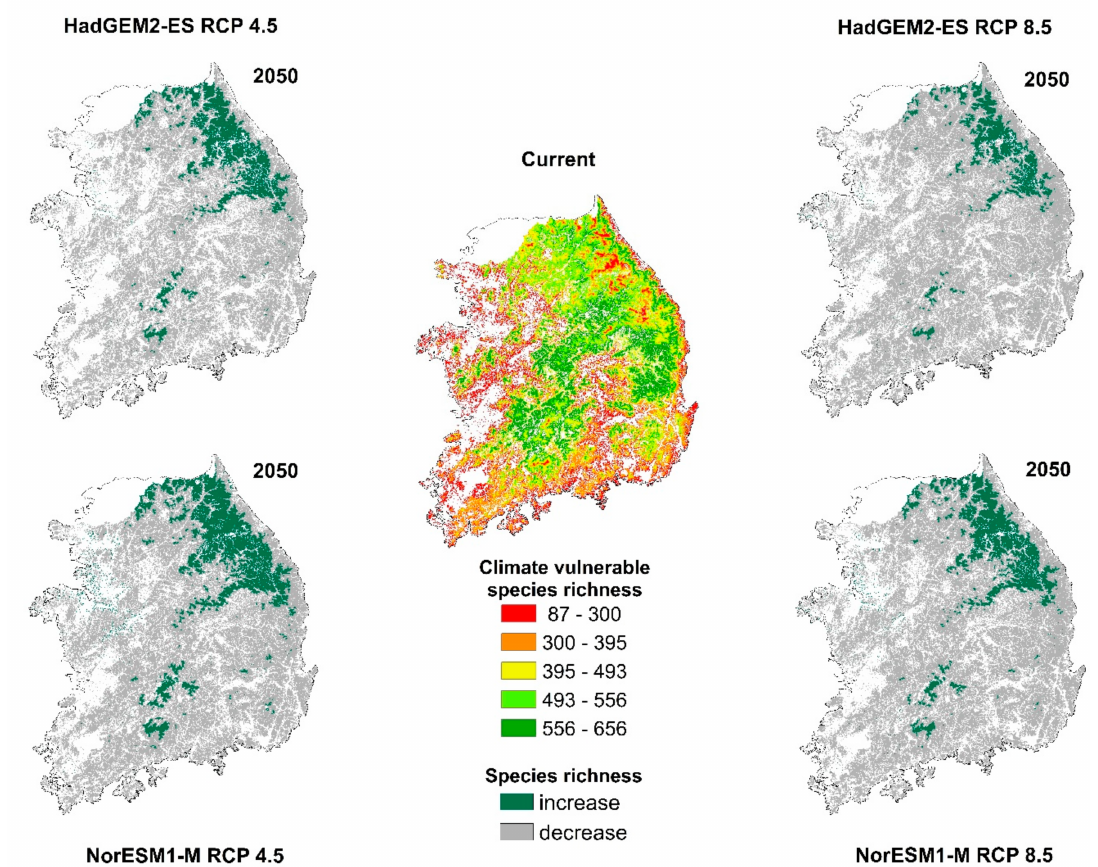
Figure 4. Species richness change for 1031 CVS (climate-vulnerable species) between the current climate and four climate scenarios. The prediction is simulated for